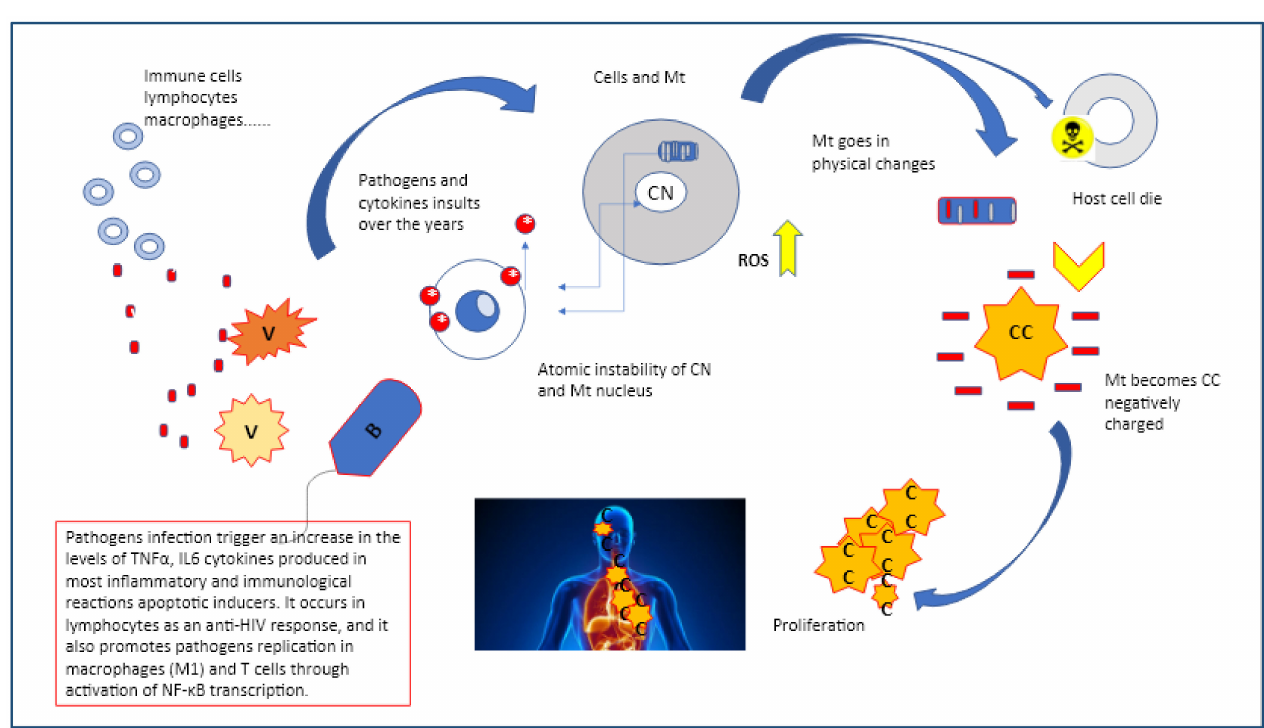
Figure 3. Pathogens as virus or bacteria may start a chain of events that trigger the mitochondria reverse process which takes place on multiple levels, initiating from the atomic compartment of both cell and mitochondria